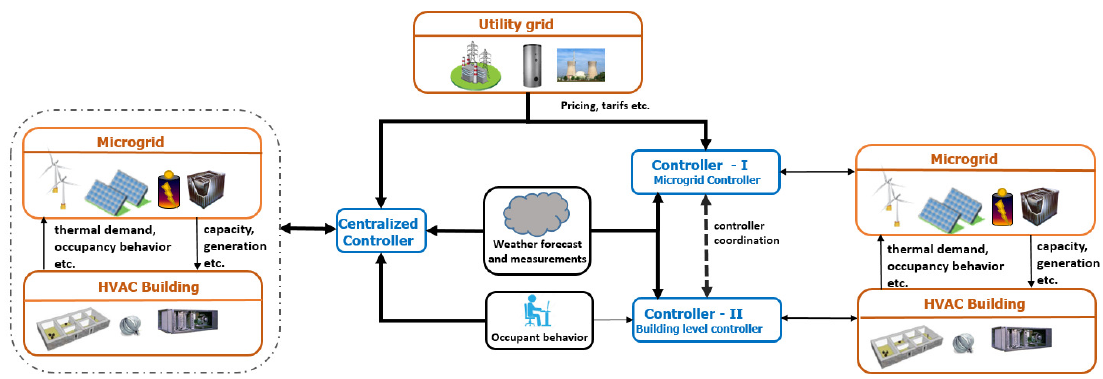
Figure 5. General controller architecture for HVAC buildings integrated with microgrid